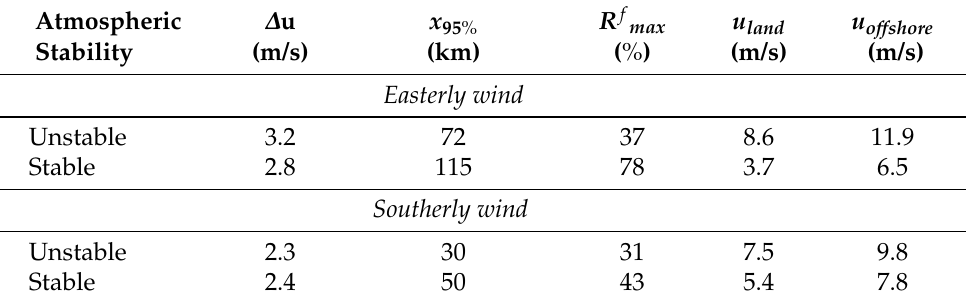
Table 3. Recap of estimated parameters ∆ u , x 95% , u o f fshore , u land , R f max from the empirical model for stable and unstable conditions for easterly and southerly unperturbed